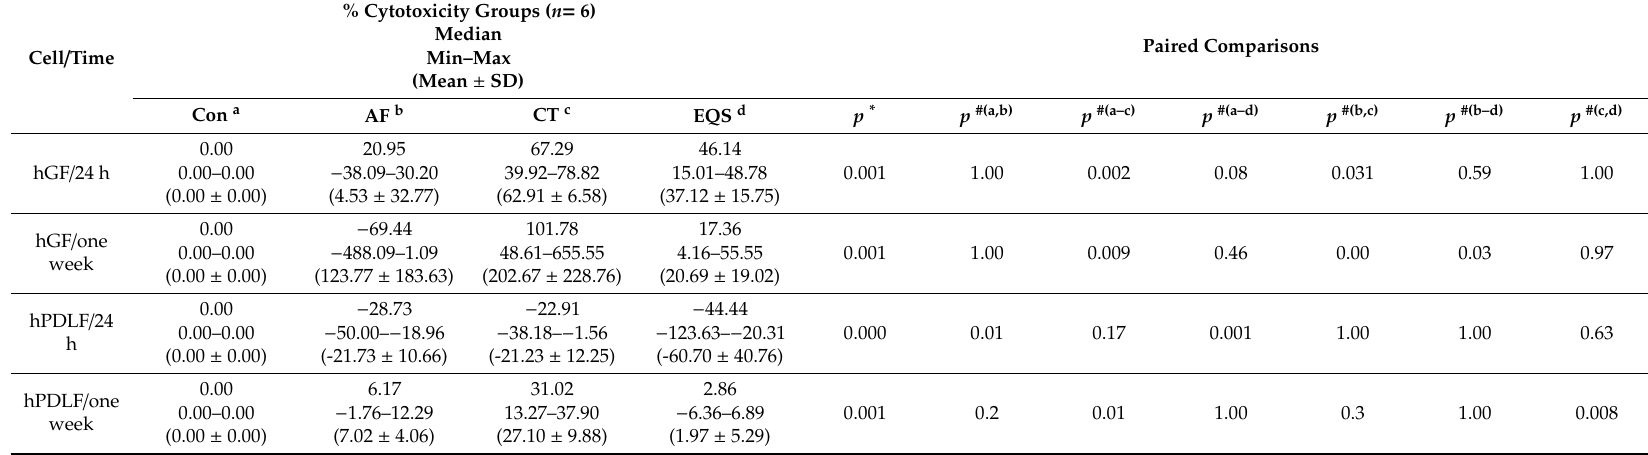
Table 1. Intergroup and paired cytotoxicity comparisons of composite resins (CRs) on hGF and hPDLF cell lines at 24 h and one week time periods.